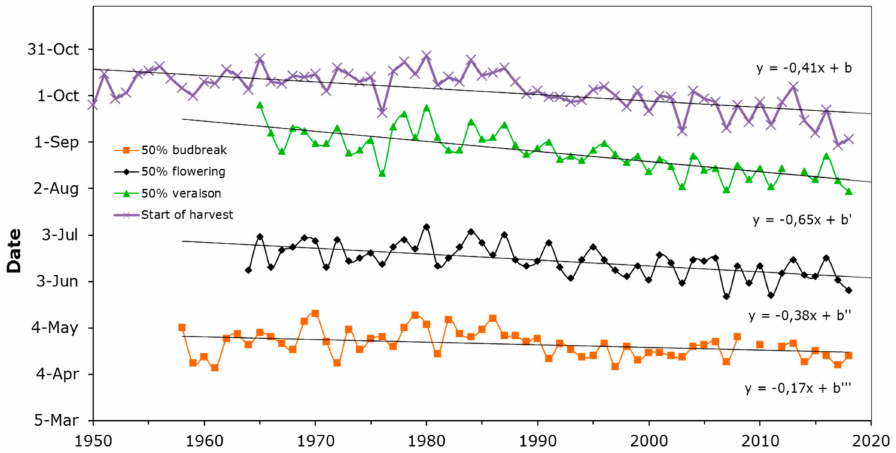
Figure 2. Long-term evolution of vine phenology for Riesling in Alsace. Data source: budbreak, flowering and veraison adapted from [48]; harvest dates from Conseil Interprofessionnel des Vins d’Alsace